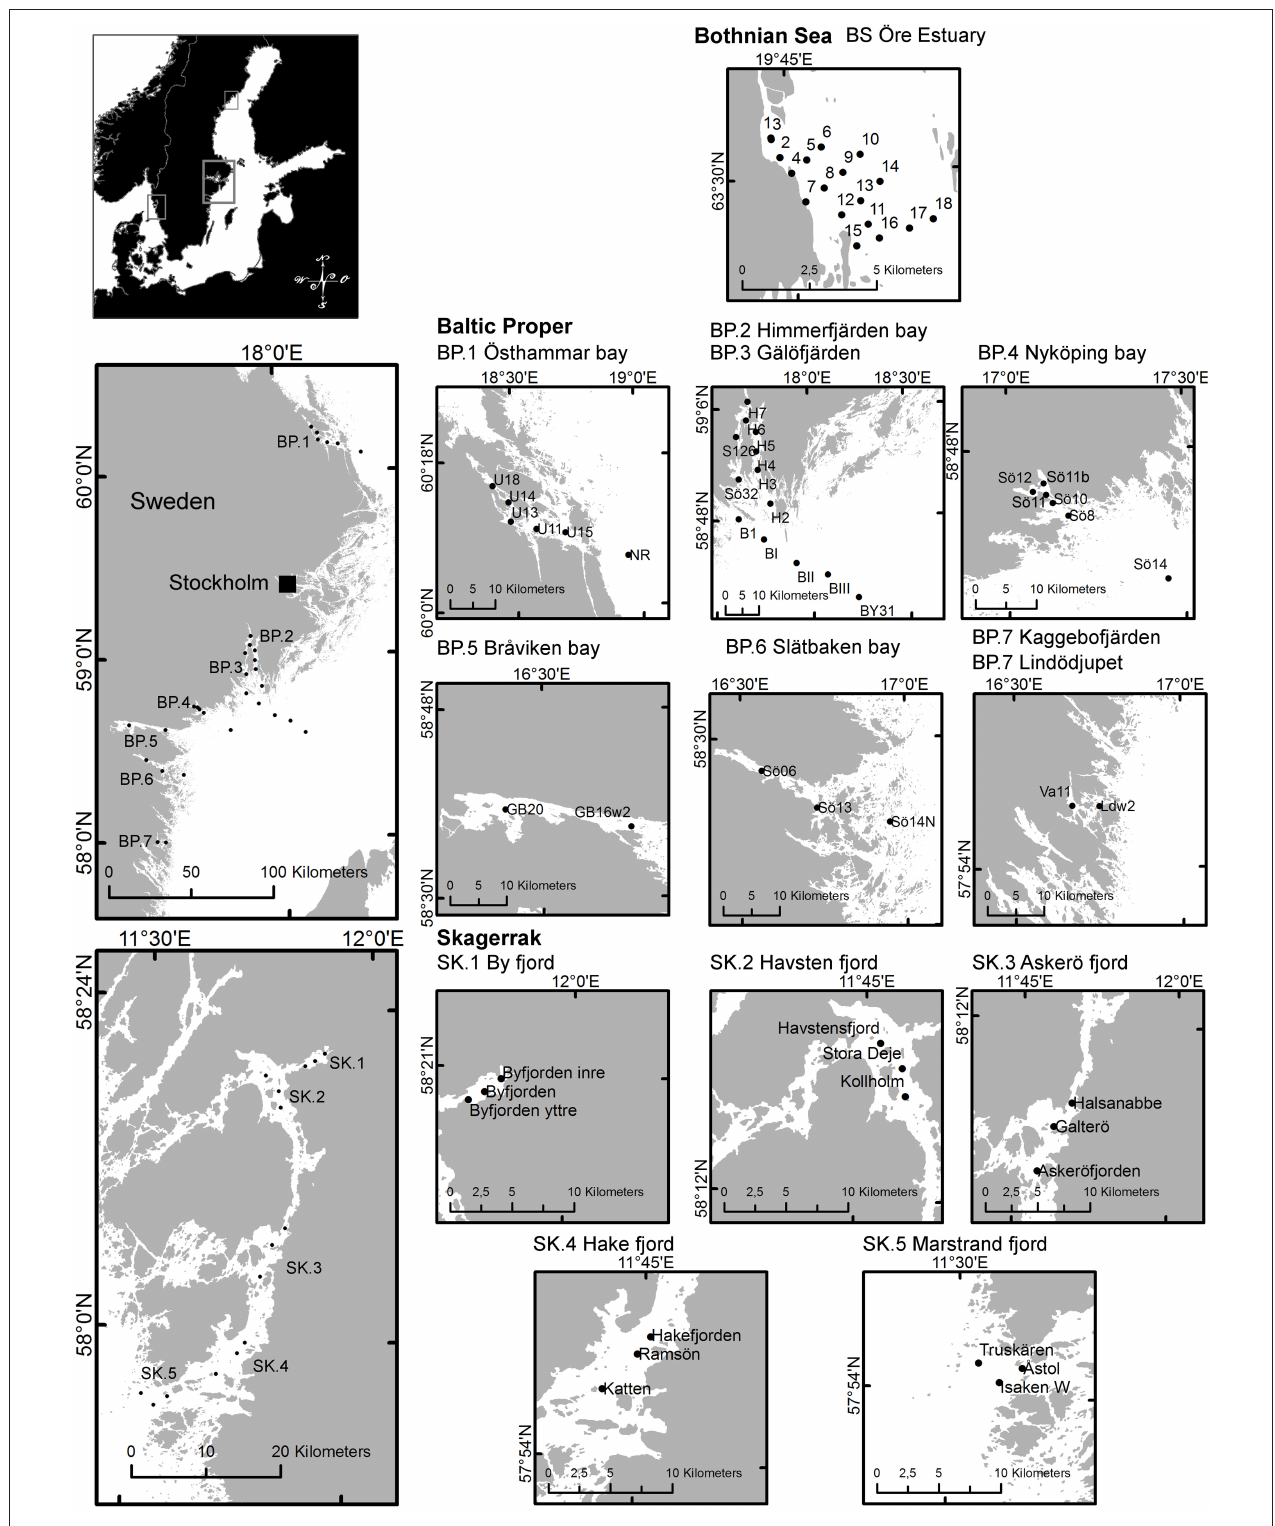
FIGURE 1 | Map of regions and sub-areas showing sampling locations. Maps © Lantmäteriet, Gävle 2010, and permission I2014/00691.